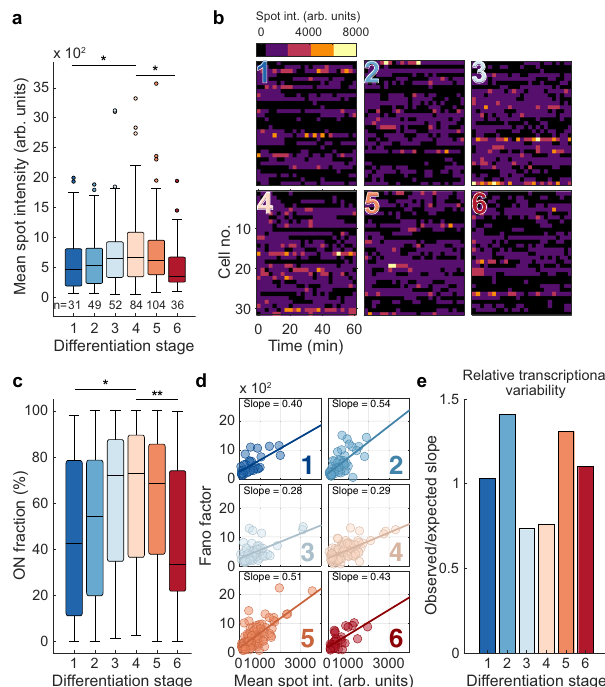
Fig. 4 | Modulation of α -globin transcription dynamics throughout ery- thropoiesis. a Distribution of mean spot intensities of individual cells through different stages of erythropoiesis. n values as shown from 5 biologically indepen- dent experiments. b Example spot intensity traces of cells within differentiation stages. Rows represent individual cells. Intensities are binned above the ON thresholdof350arbitraryintensityunits(black). c Distributionoftheproportionof timespentintheactiveONtranscriptionalstate(aboveONthreshold)foreachcell by differentiation stage. d Relationship between mean spot intensity and intra- cellular transcriptional variability (Fano factor) for individual cells across differ- entiation stages. e Relative levels of transcriptional variability throughout ery- thropoiesis de fi ned by the ratio of the observed slopes of linear regression in D compared to that of all cells pooled (expected). Boxes within boxplots show median and interquartile range, whiskers show 9th and 91st percentile of dis- * p <0.05,** p <0.01. P -values: a 1vs4: p =0.0496,4vs6:0.0319. c 1vs4: p